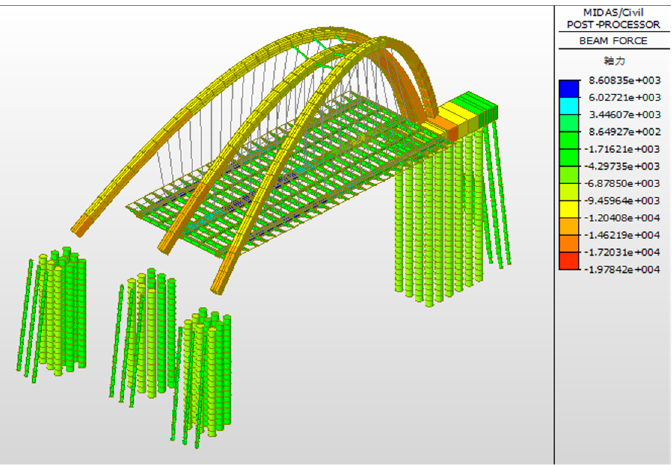
Figure 10. Axial diagram of JinDao